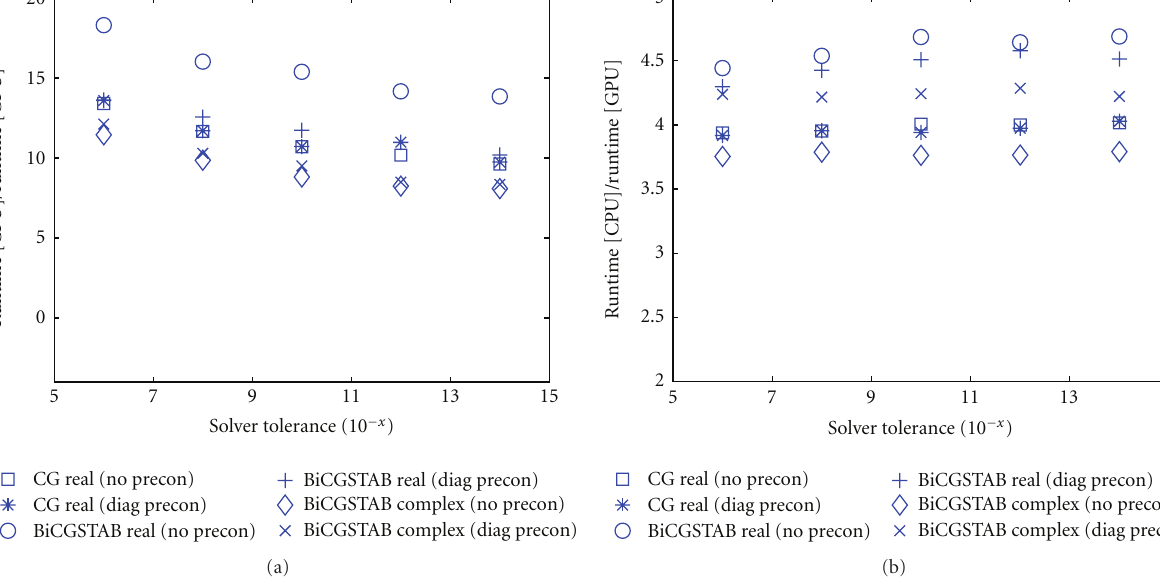
Figure 6: GPU performance factor as a function of linear solver tolerance for real and complex problems, using CG and BiCGSTAB solvers, without preconditioner and with diagonal preconditioner. (a): single-precision performance, (b): double-precision performance.